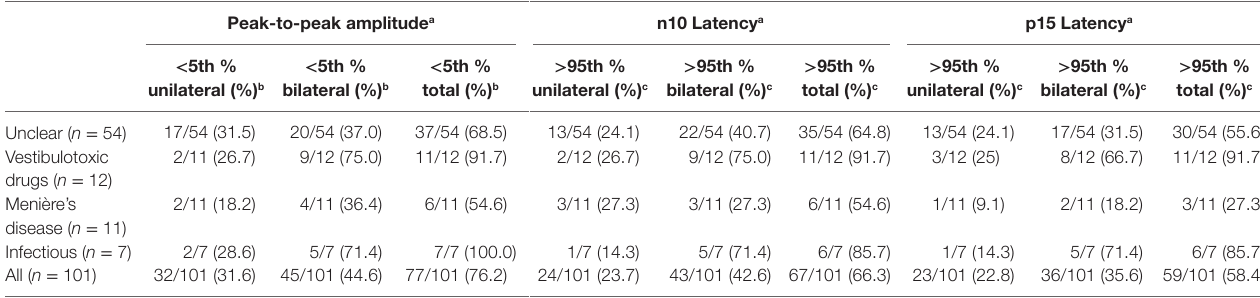
TaBle 4 | Ocular vestibular-evoked myogenic potential amplitudes and latencies. Peak-to-peak amplitude